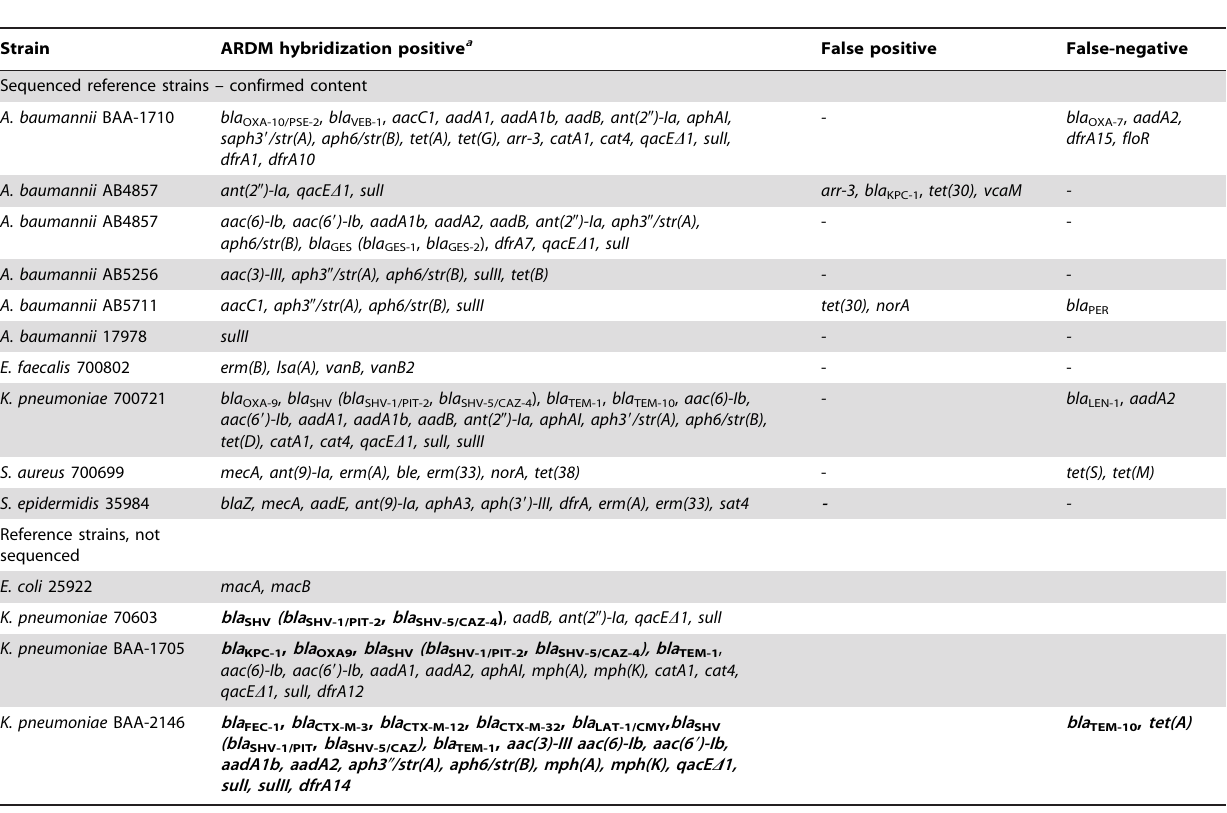
Table 3. ARDM analysis of reference